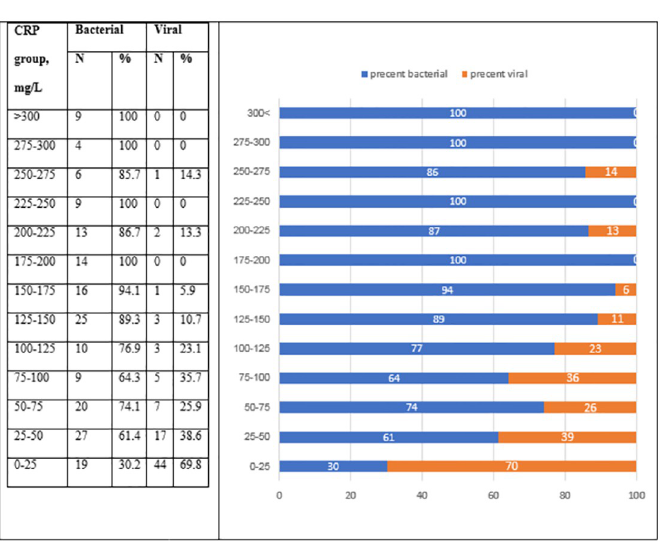
Fig 3. The ratio between bacterial (blue) and viral (orange color) infections in each range of CRP values.